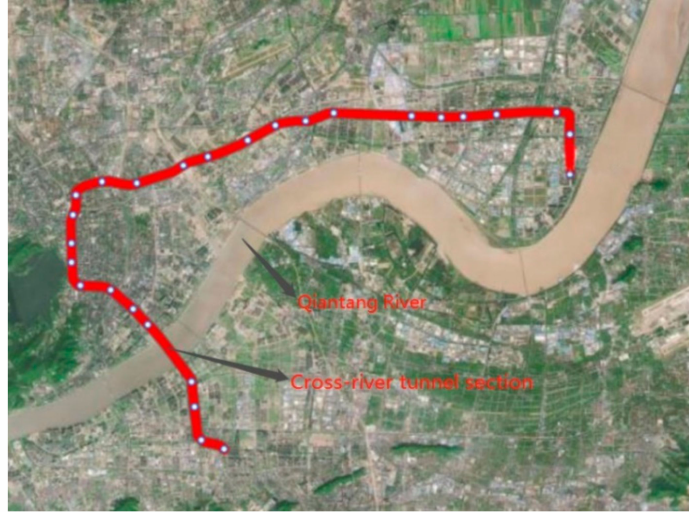
Figure 2. Hangzhou Metro Line 1 cross-river tunnel